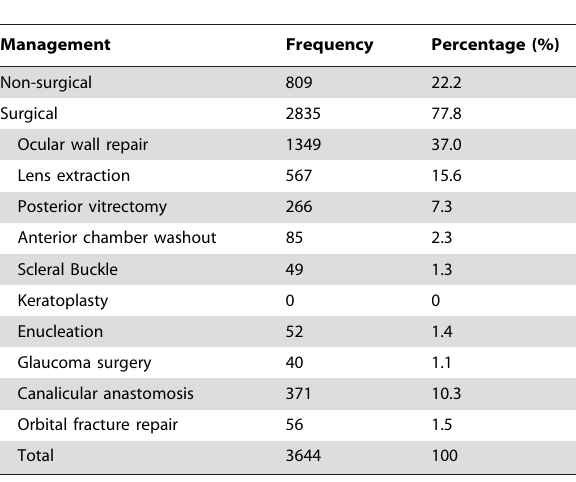
Table 3. Non-surgical and surgical management reports from initial presentation to final follow up in eye injury cases.